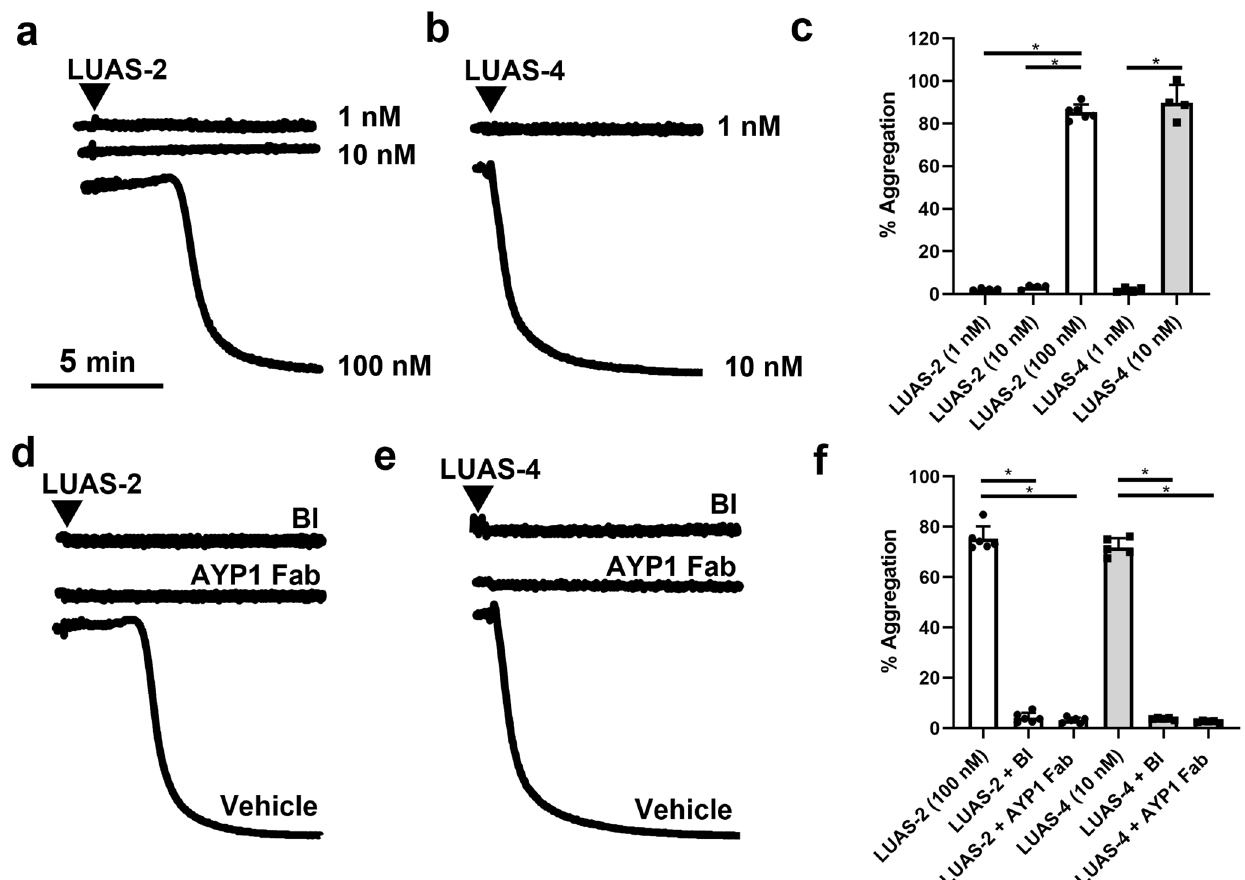
Fig. 5 Divalent and tetravalent nanobodies activate human CLEC-2 in mouse platelets. Humanised CLEC-2 mouse ( hCLEC1b KI ) platelet aggregation was monitored by light transmission aggregometry at 37°C with constant stirring at 1200 rpm for 10 min. Representative traces of washed hCLEC-2 KI platelet aggregation (2 × 10 8 platelets/ml) induced by ( a ) LUAS-2 (1-100 nM) and ( b ) LUAS-4 (1-10 nM). c Percentage of maximal platelet aggregation induced by LUAS-2 and LUAS-4 ( n = 4 – 6 biologically independent experiments). Representative traces of washed hCLEC-2 KI platelet aggregation (2 × 10 8 platelets/ ml) induced by ( d ) LUAS-2 (100 nM) and ( e ) LUAS-4 (10 nM) in the absence (vehicle) or presence of Syk inhibitor BI1002494 (BI) (500 nM) and AYP1 Fab (208 nM). Platelets were preincubated with inhibitors for 5 min at 37 °C prior to stimulation. f Percentage of platelet maximal aggregation induced by LUAS-2 and LUAS-4 in the presence of BI or AYP1 Fab ( n = 5 – 6 biologically independent experiments). Signi fi cance was measured with a one-way ANOVA with Bonferroni post-hoc for where P ≤ 0.05. Data are presented as mean ±